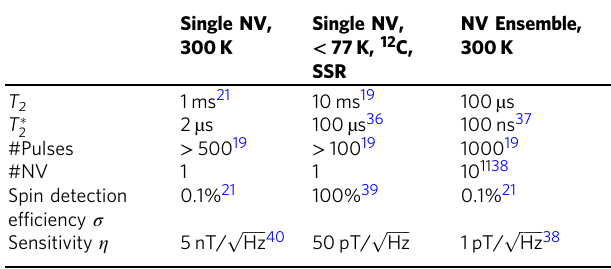
Spin detection ef fi ciency σ Sensitivity η 5 nT/ < 77K refers to cryogenic conditions, 12 C to isotopically pure diamond, and SSR to single shot readout. Sensitivities have been estimated as Z ¼ 1 = 2 pg ½ gyromagnetic ratio, σ the spin detection ef fi ciency and N NV the number of NV centers. Referencesrefertopublishedvaluesfortherespectiveparameter.Parameterswithoutreference are computed from the others or have been measured in this